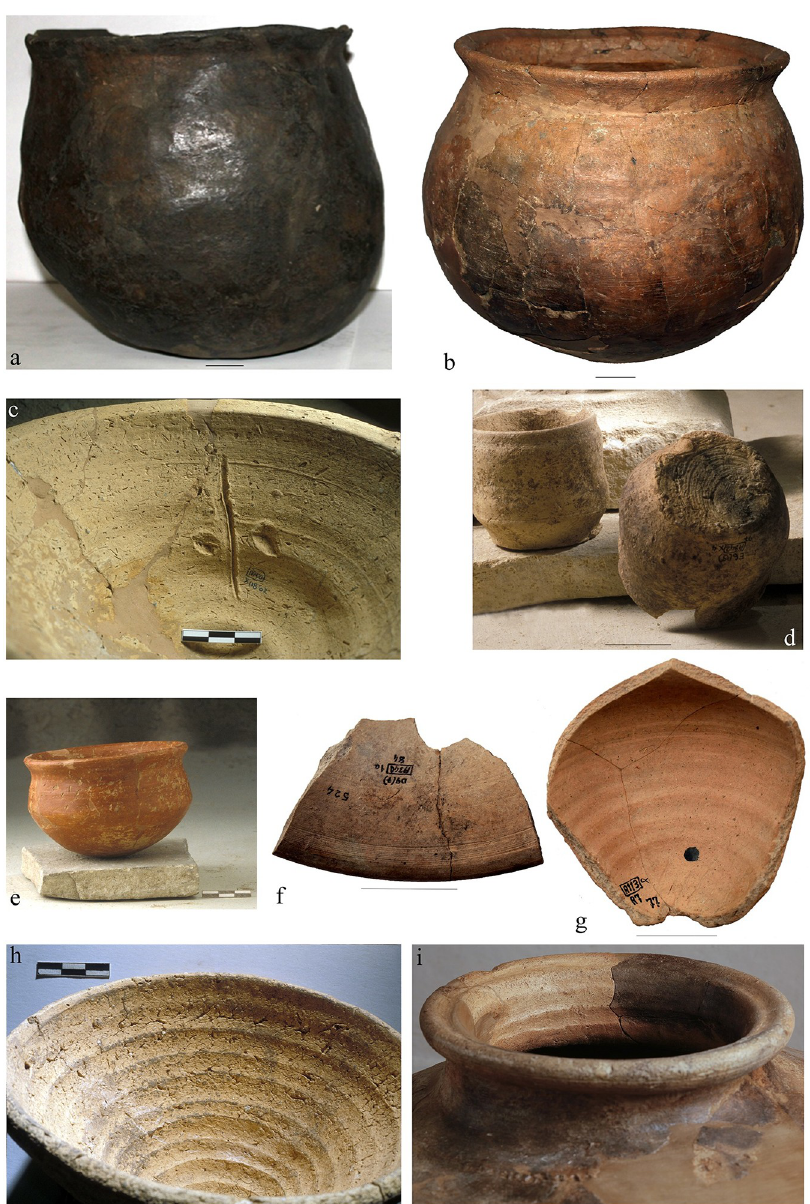
Fig 4. a. LC3-4 handmade kitchen ware; b. LC3-4 wheel-finished kitchen ware; c. LC3-4 wheel-finished mass- produced bowl with potter’s mark; d. LC3-4 wheel-finished chaff-tempered smoothed ware; e. LC3-4 wheel-finished red-slipped burnished ware; f. LC 5 wheel-finished light-colored fine ware (internal side of the foot of a high-stemmed bowl; g. wheel-finished light-colored fine ware (internal side of a jarlet); h. LC5 wheel-finished mass-produced bowl; i. neck of a LC5 wheel-finished light-colored semifine ware large jar. Image: Archive of the Missione Archeologica Italiana in Anatolia Orientale (MAIAO).